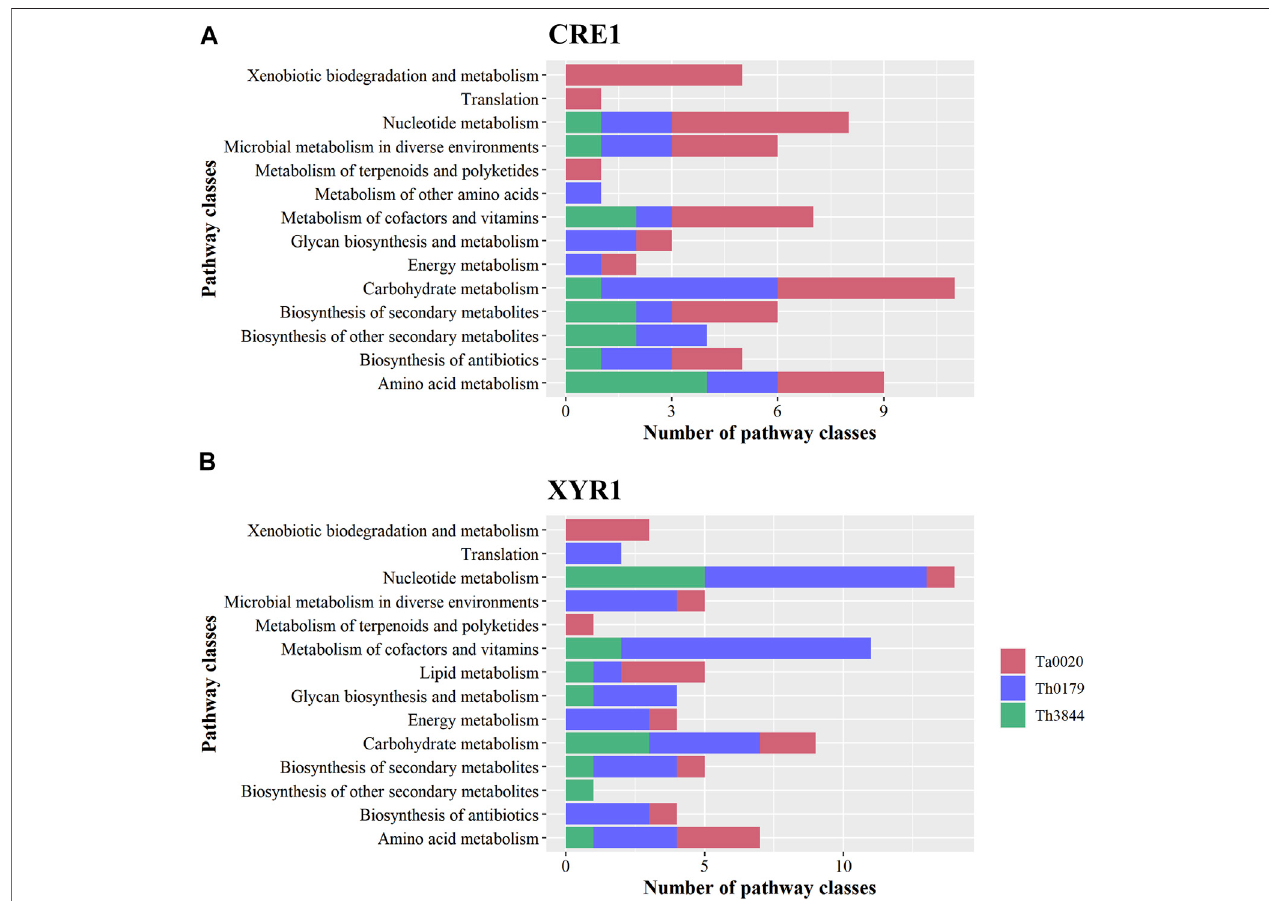
FIGURE 2 | KO functional classi fi cation of the transcripts identi fi ed in the cre1 and xyr1 groups. The sequences related to the enzymes coexpressed with cre1 (A) and xyr1 (B) were annotated according to the main KO functions of Th3844, Th0179, and Ta0020. For all evaluated strains, 14 pathway classes were observed in each TF, and 13 classes were shared between the two regulators. However, the number of identi fi ed enzymes in a given pathway class differed in each strain. Each strain is represented by a different color. Ta0020: T. atroviride CBMAI-0020; Th0179: T. harzianum CBMAI-0179; Th3844: T. harzianum IOC-3844; KO: Kyoto Encyclopedia of Genes and Genomes